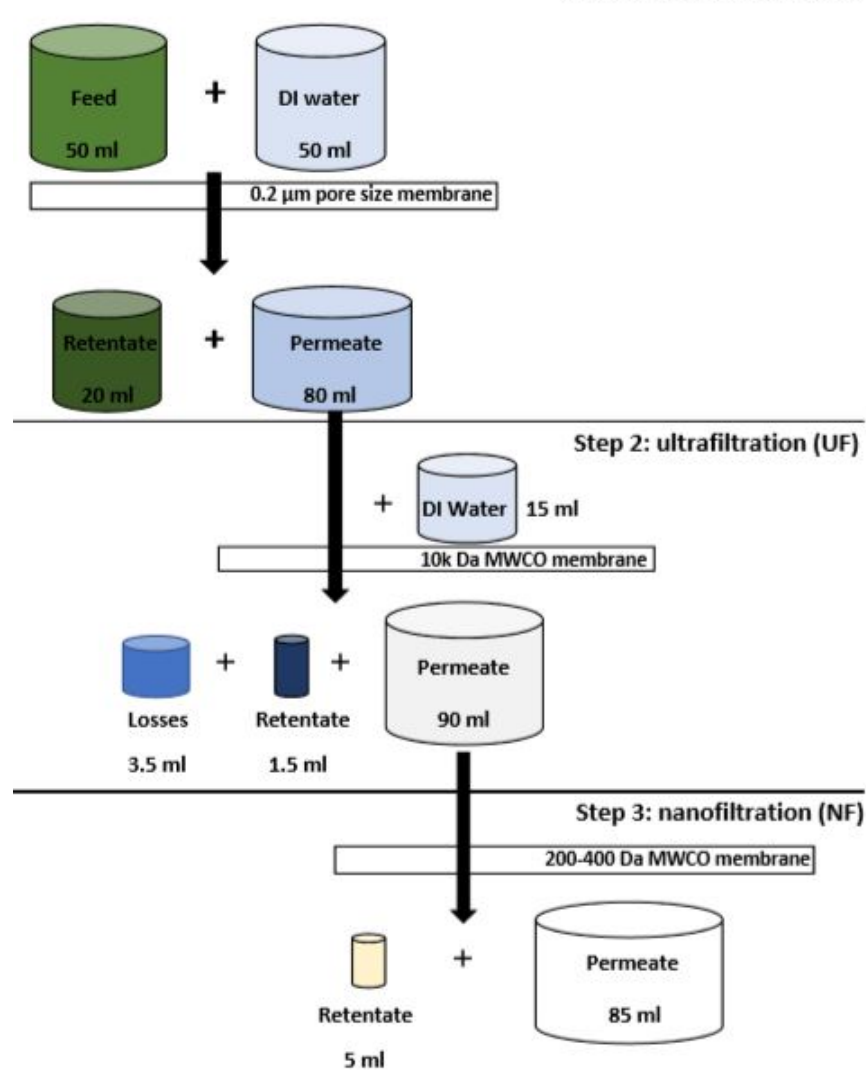
Figure 1. Schematic of the sequential three-stage membrane filtration process.